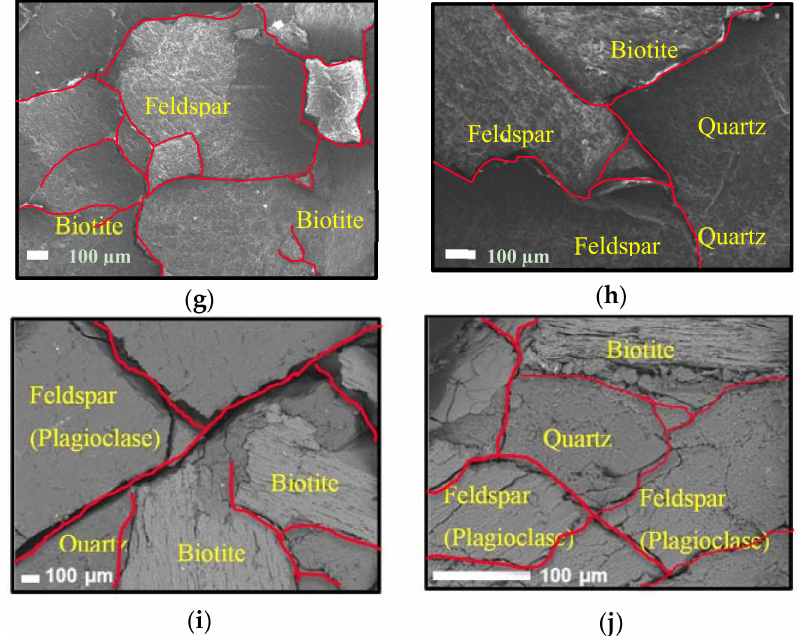
Figure 5. SEM images of heat-treated rock slices ( a ) 100 ◦ C RC, ( b ) 100 ◦ C SC, ( c ) 200 ◦ C RC, ( d ) 200 ◦ C SC, ( e ) 400 ◦ C RC, ( f ) 400 ◦ C SC, ( g ) 600 ◦ C RC, ( h ) 600 ◦ C SC, ( i ) 800 ◦ C RC and ( j ) 800 ◦ C SC where RC denotes Rapid cooling and SC denotes: Slow cooling) Note: SEM image ( j ) under 800 ◦ C SC was taken